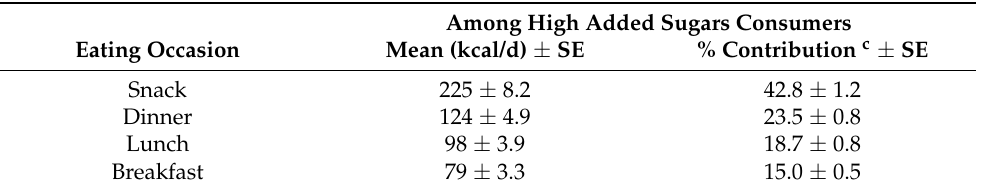
Table 3. Mean energy from added sugars intake by eating occasions among high consumers a , NHANES 2015–2018, Day 1 dietary recall ( n = 3236) b .